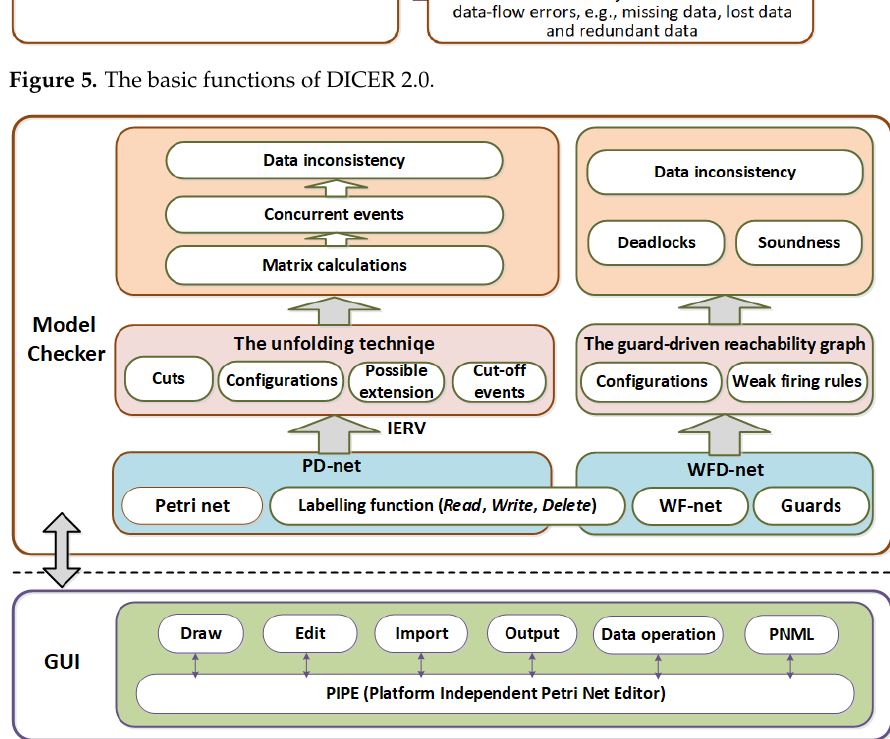
Figure 6. The basic framework of DICER